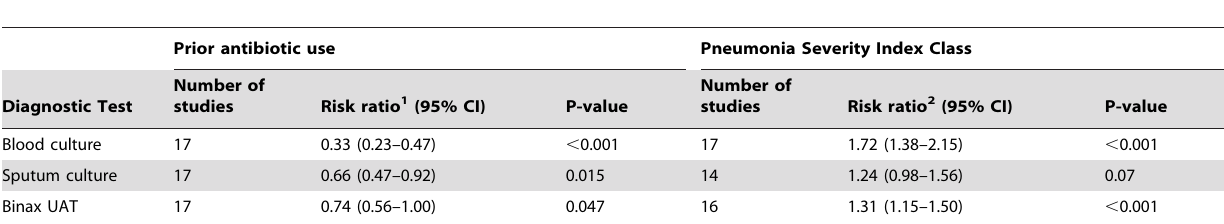
Table 3. Meta-analysis of the association of prior antibiotic use and PSI class on the yield of blood culture, sputum culture, and the Binax